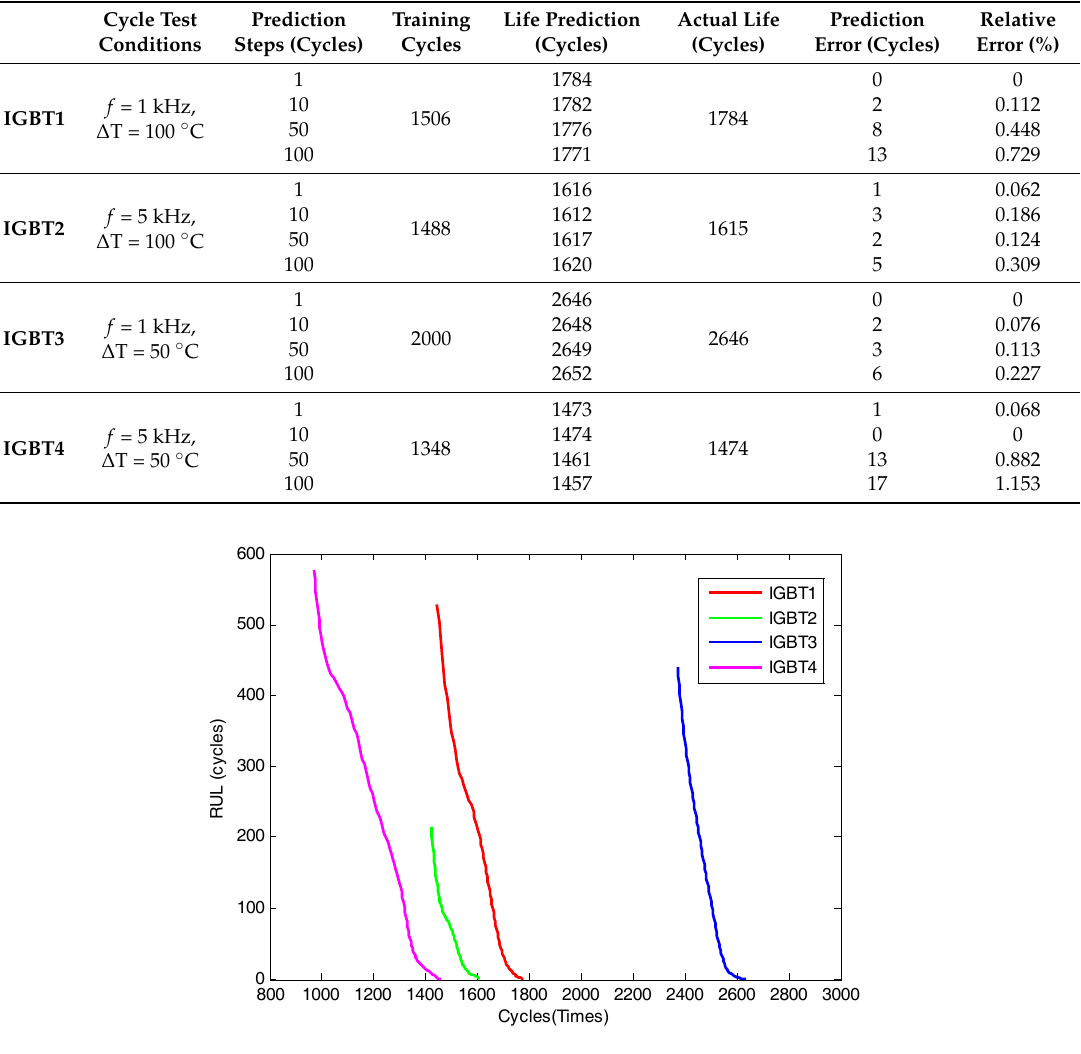
Table 8. The life prediction error result for different methodologies.